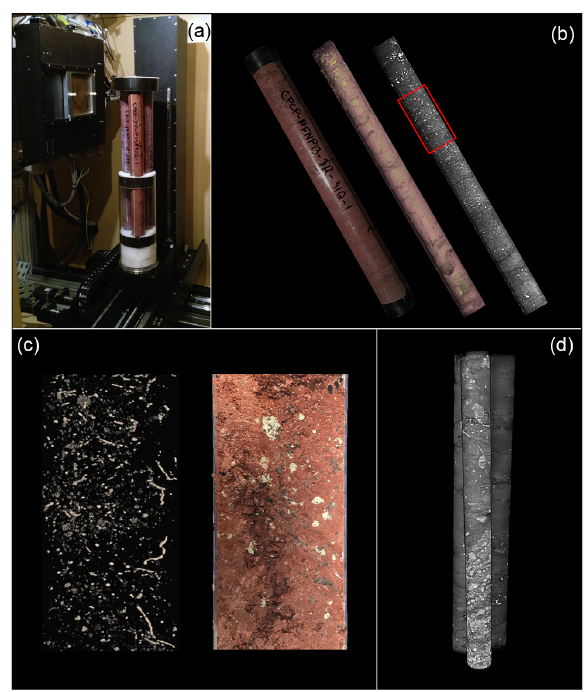
Figure 8. CT scans of CPCP-PFNP13-1A core: (a) three core seg- ments bundled with aluminum rod at center in the 450kV GE Titan X-ray source and Perkin Elmer flat-panel detector at the University of Texas High Resolution X-ray CT Facility, Austin, TX – visible in the front is CPCP-PFNP13-A1-31Q-1 (cores are approximately 0.7m long); (b) four images of core segment CPCP-PFNP13-A1- 31Q-1 at core depths 37.5 to 38.2m is equivalent to 32.5 to 33.1m stratigraphic depth in the basal Owl Rock Member of the Chinle Formation (left image is in visible light with core in its liner, mid- dle image is a colorized CT volume with liner digitally stripped off; right image is a CT volume with an addition 2mm stripped off to digitally clean off drilling mud – red box is interval shown in c ); (c) enlargement of CT volume shown in red box in (b) , left image is CT volume filtered to highlight carbonate-rich rhizoliths (root traces) and right image is digital photograph of the same inter- val in the slabbed core (core is ∼ 6 . 35cm in diameter) (see https:// www.youtube.com/watch?v=T05S7R7dP7M, last access: Septem- ber 2018); (d) bundle of three core segments of Owl Rock Member of the Chinle Formation from CT animation of CPCP- PFNP13-1A-25Q2 (foreground); CPCP-PFNP13-1A-26Q2; CPCP- PFNP13-1A-27Q1 with CPCP-PFNP13-1A-25Q2 volume show- ing conglomerate and clear bedding inclined to left (cores are ap- proximately 0.7m long) (see https://www.youtube.com/watch?v= ynM-H8_Qu7A&feature=youtu.be, last access: September